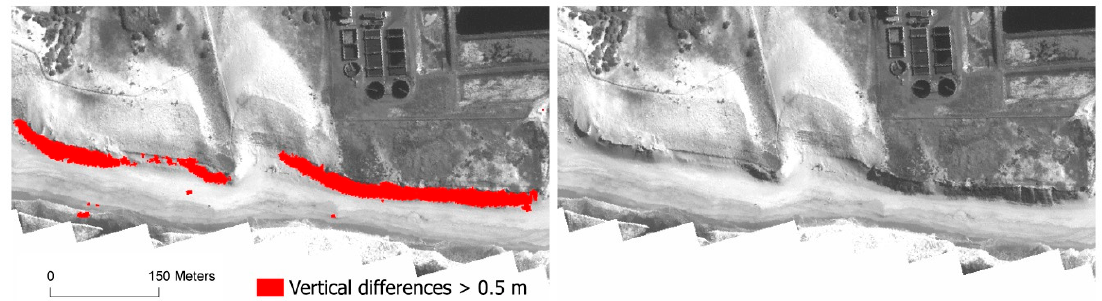
Figure 5. Example of the errors observed on the dune face, over the Pleiades orthophotomap; the presence of shadows on the dune face ( right image ) coincides with the area where the largest differences (>0.5 m in red, left image) were observed ( left image ).